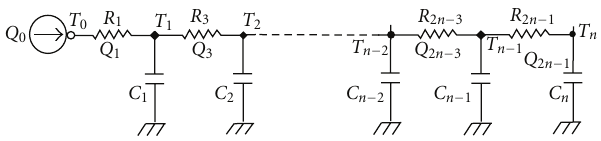
Figure 10: Thermal network model (Model